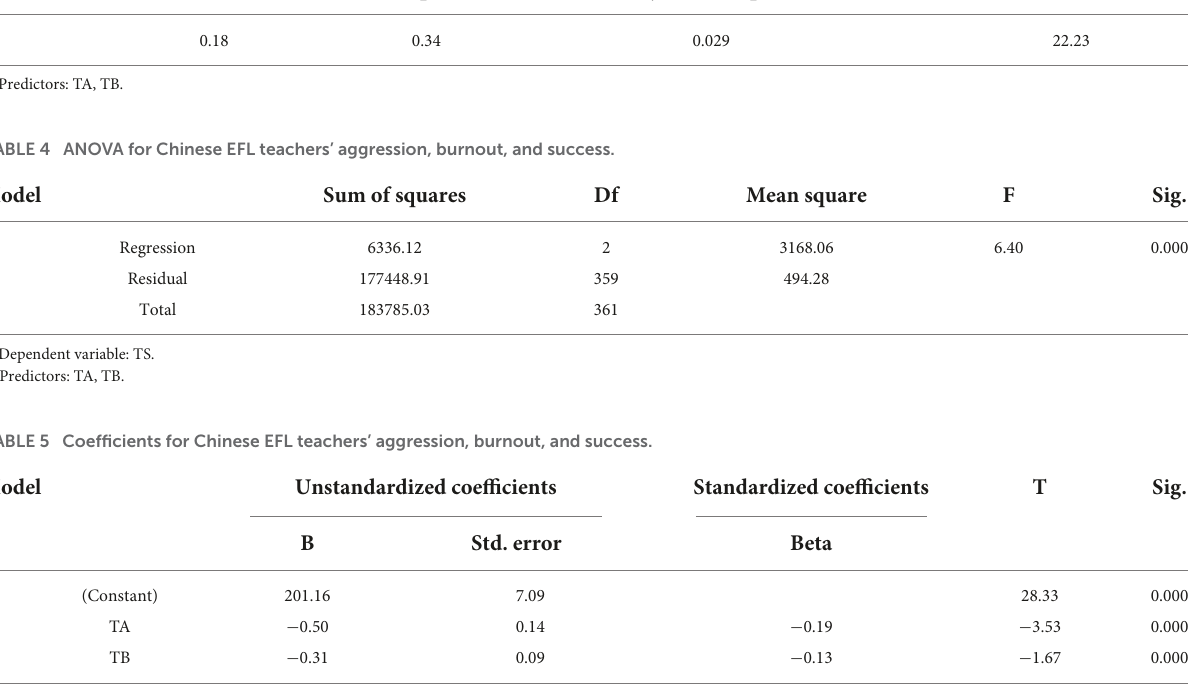
TABLE 3 Model summary for Chinese EFL teachers’ aggression, burnout, and success. Model